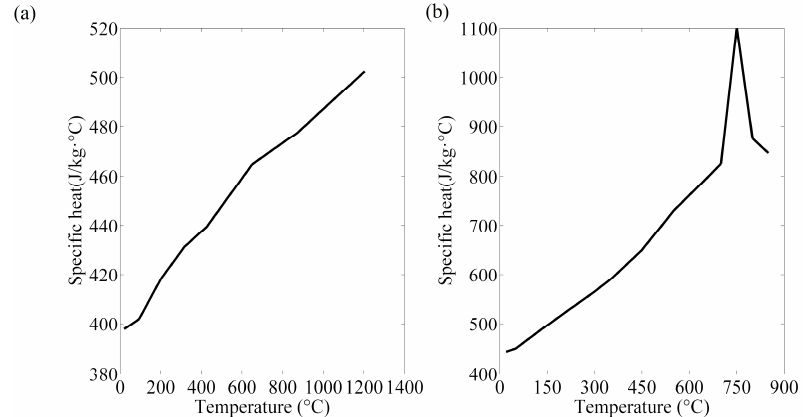
Figure 6. Specific heat of the electrode ( a ) and DP600 ( b ).